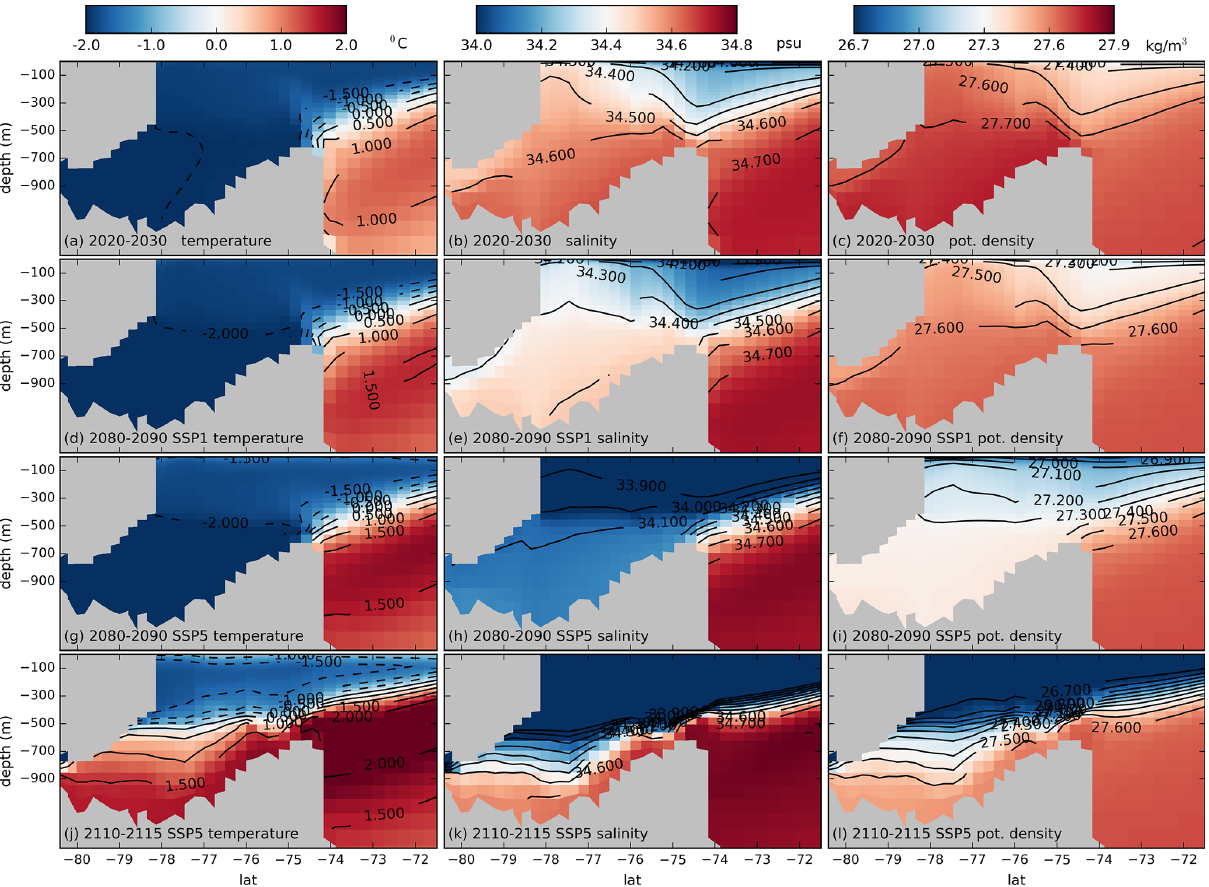
Figure 9. Temperature, salinity and potential density profile in a Filchner Trough section (indicated by the red line in Fig. 8a) for (a–c) SSP5– 8.5 for years 2020–2030, (d–f) SSP1–1.9 for years 2080–2090, (g–i) SSP5–8.5 for years 2080–2090 and (j–l) SSP5–8.5 for years